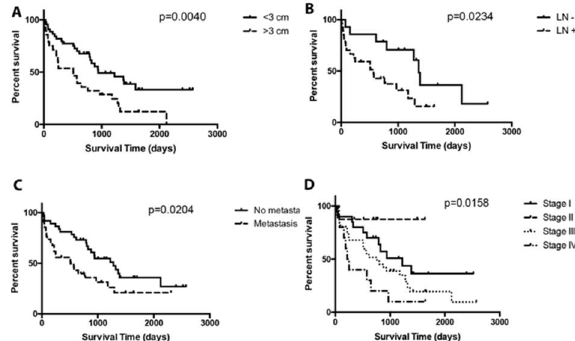
Figure 1. Kaplan–Meier survival plot of dogs with MCTs according to tumour size, presence of documented lymph node (LN) metastasis, presence of any type of metastasis (MTS) and WHO staging system classification. Vertical tick marks along survival curves represent censored dogs. ( A ) The median survival time for dogs with MCTs > 3 cm was 510 days and for dogs with MCTs < 3 cm, the median ST was 943 days ( p = 0.0040). ( B ) The median survival time for dogs with lymph node metastasis (LN + ) was 570 days, and for dogs without lymph node metastasis (LN − ) it was 1362 days ( p = 0.0234). ( C ) The median survival time for dogs with metastasis (MTS + ) was 511 days, and for dogs without metastasis (MTS − ) it was 1276 days ( p = 0.0204). ( D ) The median survival times for dogs with stage I, stage II, stage III, and stage IV were 1221, not reached, 763, and 234 days, respectively ( p = 0.0158).